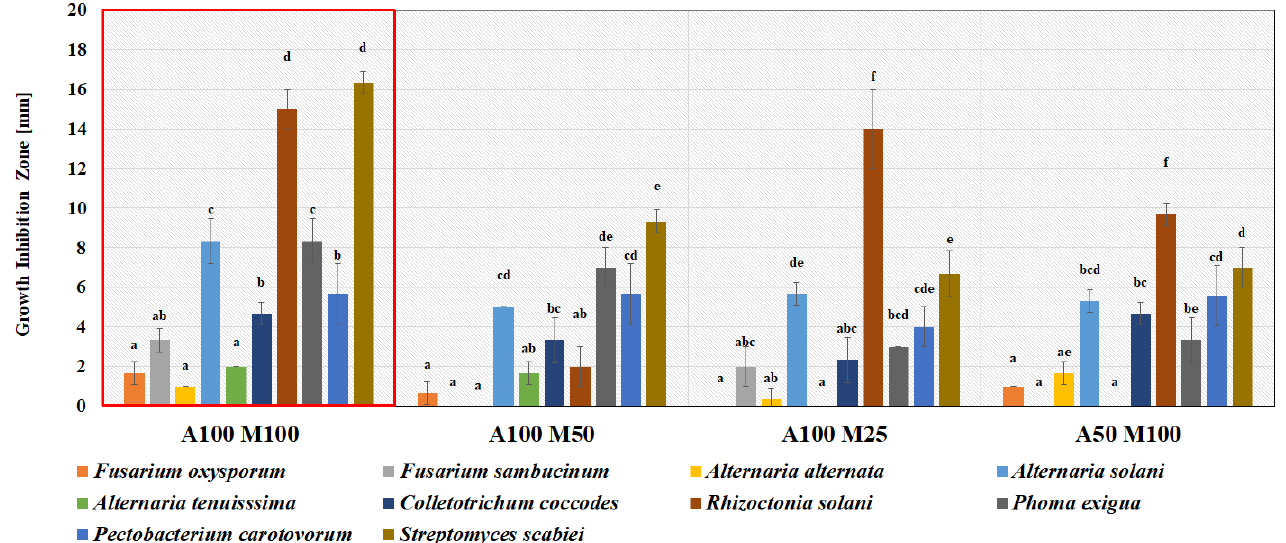
Figure 4. Antimicrobial activity of L. plantarum KB2 LAB 03 cultivated on different variants of acid whey-based media against potato phytopathogens measured as growth inhibition zones in the agar-well diffusion method. A—group of nitrogen sources (yeast extract, peptone K); M—group of mineral sources (ammonium citrate, dipotassium phosphate, sodium acetate, magnesium sulphate heptahydrate, magnesium sulphate tetrahydrate). A100 M100—acid whey medium supplemented with 100% base concentration of group A supplements and 100% base concentration of group M supplements. The following numbers (50, 25, 12.5) indicate supplementation with a certain percentage of the initial concentration of group A and M supplements. The specific concentrations of each component are presented in Section 2.4.1 point of Materials and Methodology section. a–f—results with different letters within the sample are significantly different (Tukey’s test, α = 0.05).